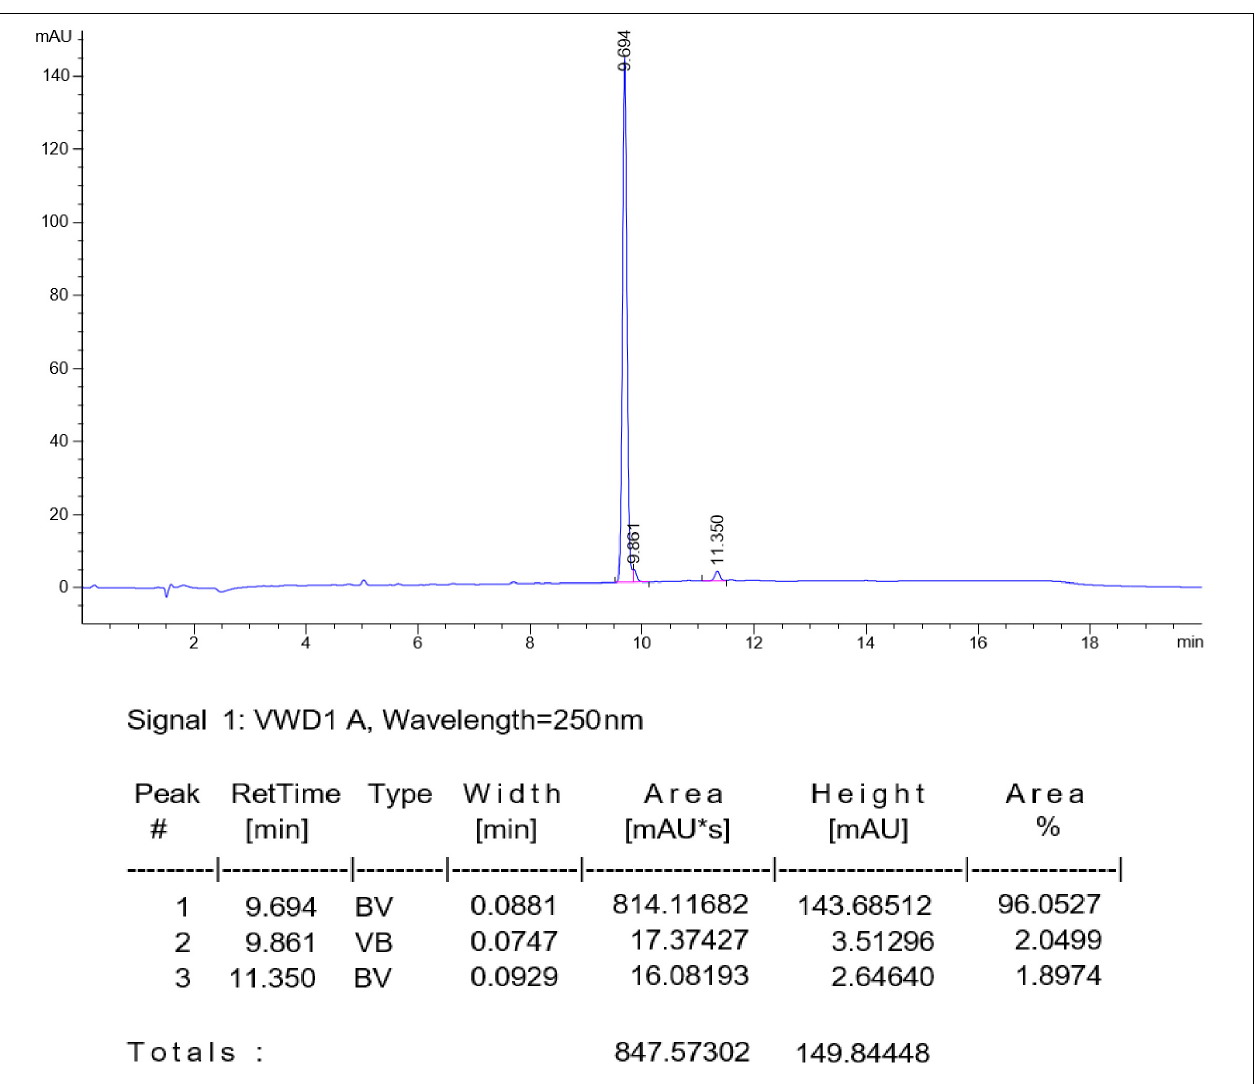
FIGURE 3 | High-resolution mass spectrometry (HRMS) identification of SYG-180-2-2.